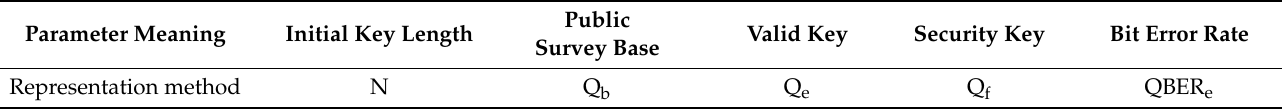
Table 7. Symbol representation and